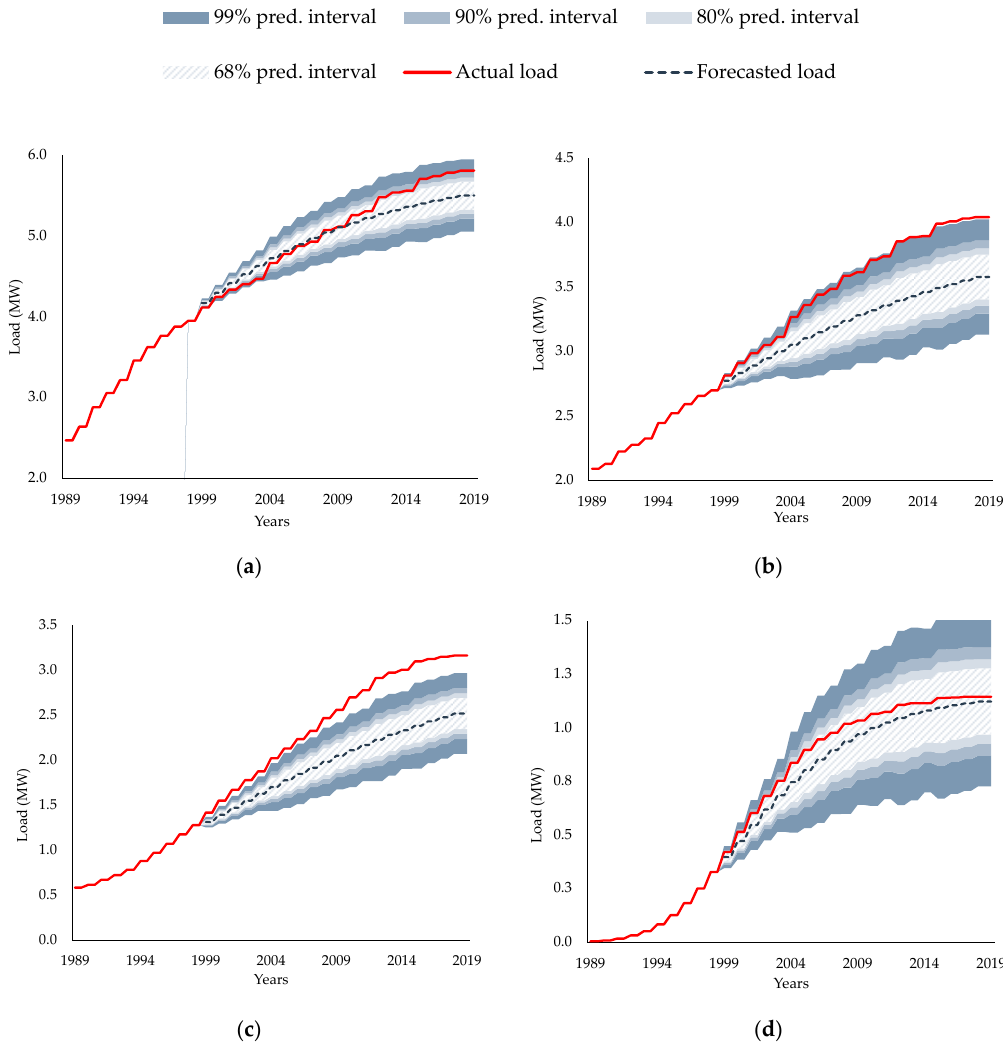
Figure 6. Probabilistic load forecasting of representative small areas considering the RMSE of the total area (service territory): ( a ) small area {2, 4} (Small area {x, y} denotes the square located in the x-th row and the y-th column of the grid of the service territory); ( b ) small area {1, 5}; ( c ) small area {12, 9}; ( d ) small area {4, 9}.